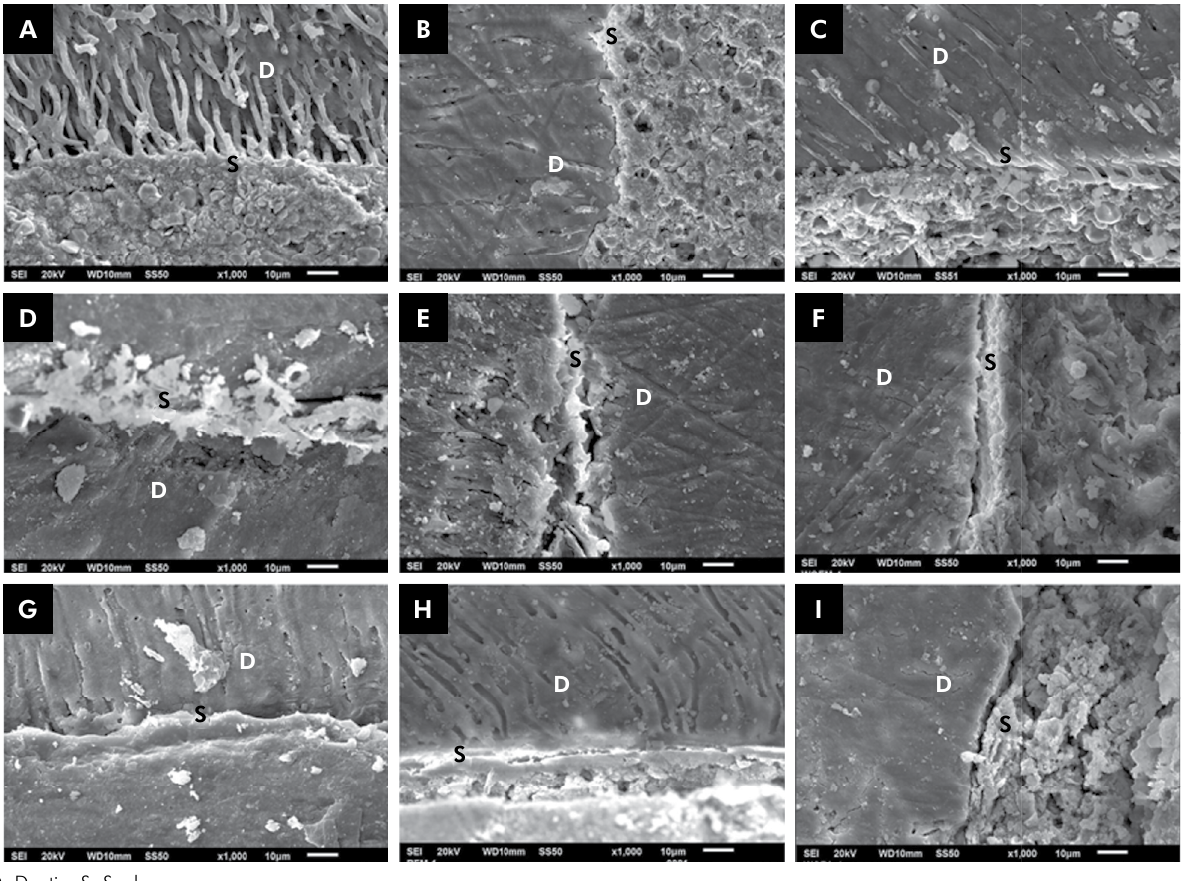
Figure 4. SEM images showing the bonding interfaces (×1,000) of filling materials with dentin. (A) Interface of AH Plus associated with the lateral compaction technique in the coronal third. Note the presence of several long tags. Root-filling produced in the middle third with AH Plus associated with Reciproc (B) and WaveOne (C), demonstrating a closer adaptation of the filling material to the dentin. Interfaces produced by Epiphany SE associated with lateral compaction (D), Reciproc (E) and WaveOne (F) in the coronal third (middle third at image 4f). Gaps were observed when this sealer was used, independent of the filling technique. Interfaces produced by MTA Fillapex with lateral compaction (G), Reciproc (H) and WaveOne (I) in the coronal, middle and apical thirds, respectively. Note the absence of tags and the presence of gaps that are mainly associated with single-cone